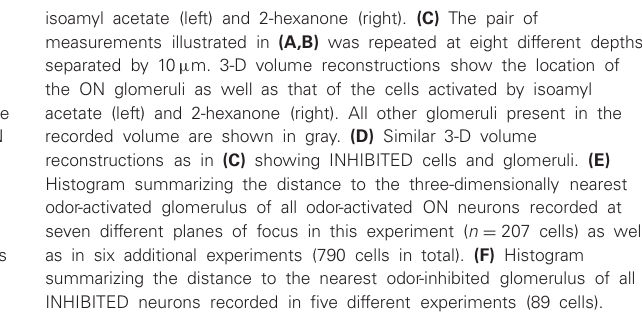
isoamyl acetate (left) and 2-hexanone (right). (C) The pair of measurements illustrated in (A,B) was repeated at eight different depths separated by 10 µ m. 3-D volume reconstructions show the location of the ON glomeruli as well as that of the cells activated by isoamyl acetate (left) and 2-hexanone (right). All other glomeruli present in the recorded volume are shown in gray. (D) Similar 3-D volume reconstructions as in (C) showing INHIBITED cells and glomeruli. (E) Histogram summarizing the distance to the three-dimensionally nearest odor-activated glomerulus of all odor-activated ON neurons recorded at seven different planes of focus in this experiment ( n = 207 cells) as well as in six additional experiments (790 cells in total). (F) Histogram summarizing the distance to the nearest odor-inhibited glomerulus of all INHIBITED neurons recorded in five different experiments (89